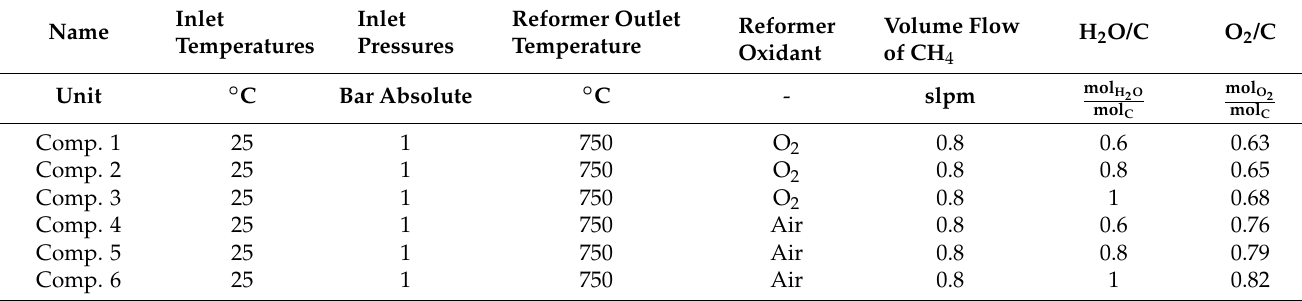
Figure 2. Scheme of the simulation model of the SOFC-reformer system. Table 1. Initial gas compositions for auto-thermal reforming of